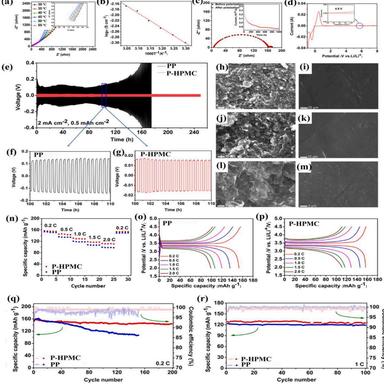
Electrochemical performances of P-HPMC. (a) Ionic conductivity of P-HPMC in the temperatures range from 30 ◦C to 55 ◦C. (b) The fitting relationship between ionic conductivity and different temperatures from 30 ◦C to 55 ◦C. (c) EIS plots and chronoamperometry curves of Li/P-HPMC/Li cell. (d) cyclic voltammogram of SS/P-HPMC/Li cell. (e) The galvanostatic cycling diagrams of Li/LE/Li and Li/P-HPMC/Li symmetrical batteries at the density of 2 mA cm− 2 for 0.5 mAh cm− 2 . (f) and (g) Voltage profile comparison